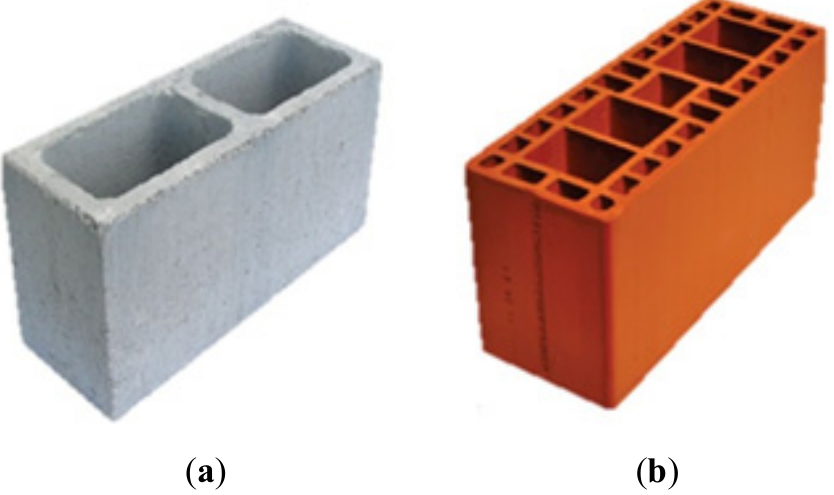
Figure 1. ( a ) Structural concrete block. ( b ) Structural ceramic block. Table 1. Properties and data of the products.